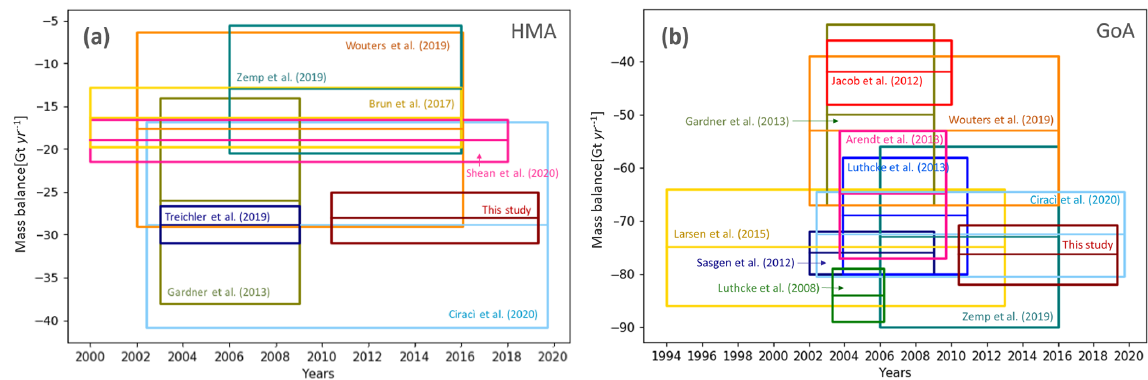
Figure 8. Estimates of mass balance [Gtyr − 1 ] as published in different studies for High Mountain Asia (a) and Alaska (b)